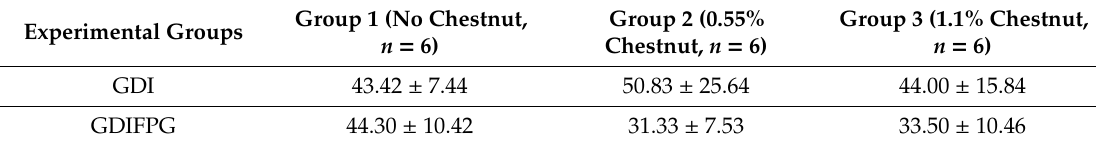
Table 6. Genetic damage index (GDI) with and without formamidopyrimidine DNA glycosylase (FPG) determined by comet assay (mean ± standard error).